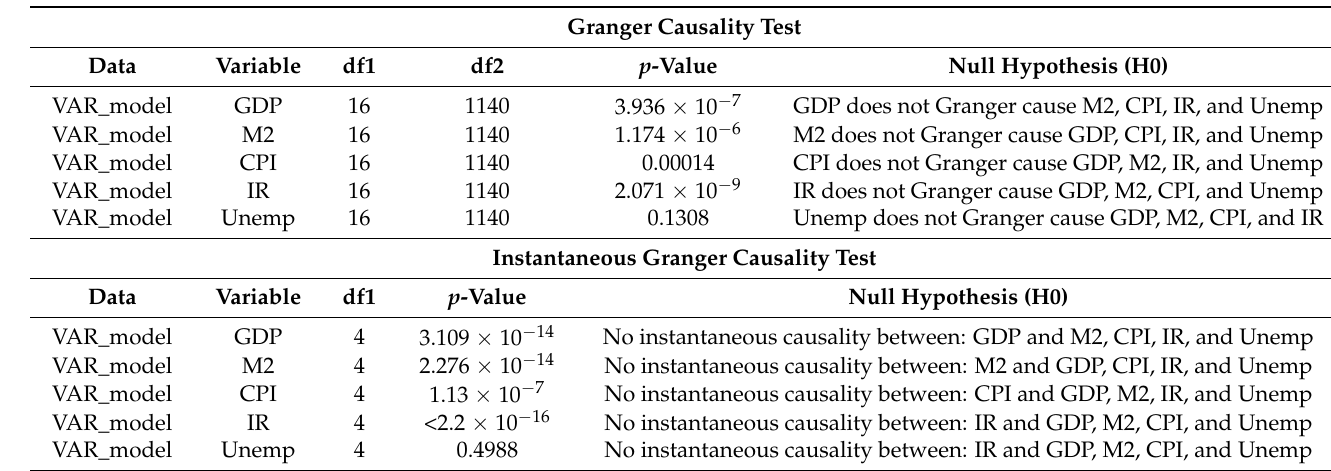
Figure 4. Structural break test. Table 11. Granger causality test for Growth Domestic